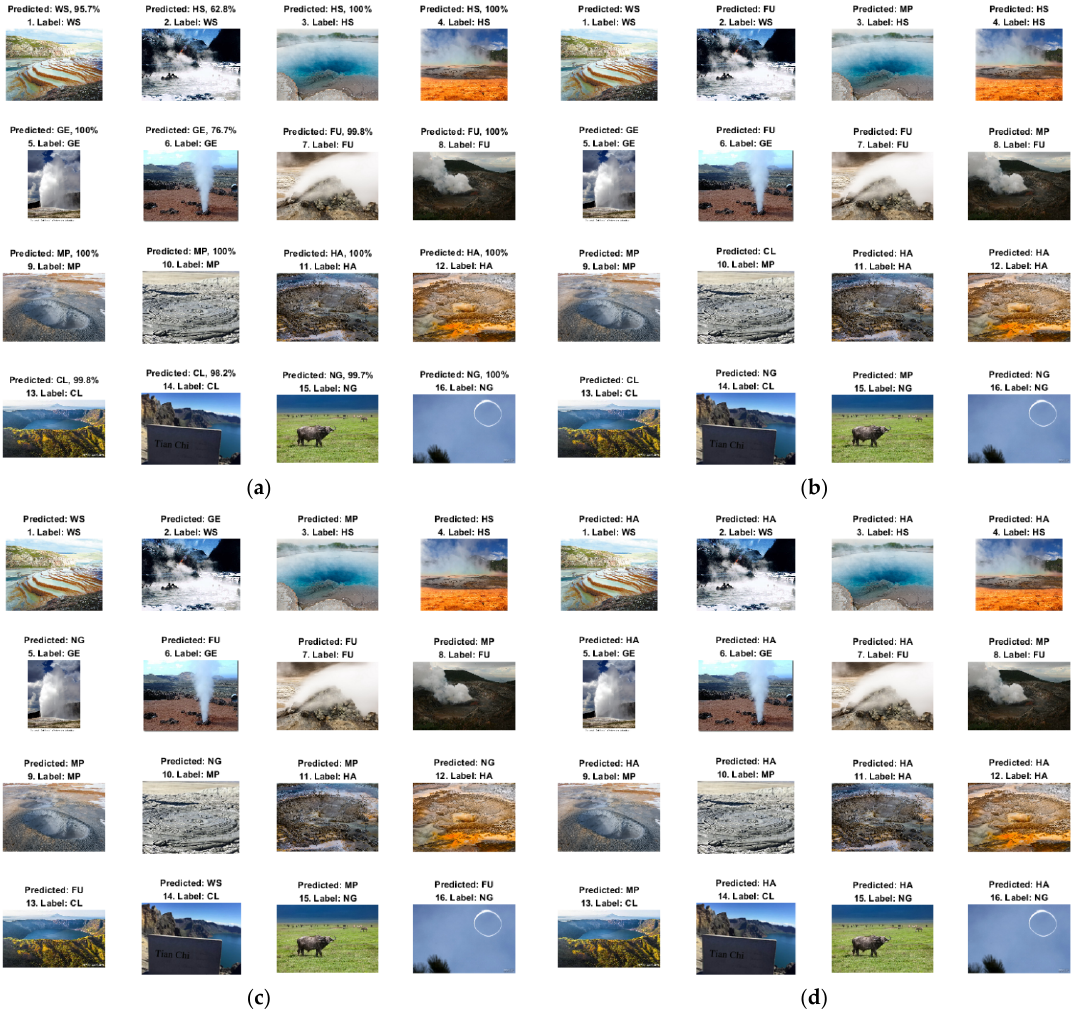
Figure 5. Test image presentations of different classifier models: ( a ) The GoogLeNet model, ( b ) the Support Vector Machine (SVM) model, ( c ) the Decision Tree (DT) model, and ( d ) the K-Nearest Neighbor (KNN) model. WS is short for warm spring; HS is short for hot spring; GE is short for geyser; FU is short for fumarole; MP is short for mud pot; HA is short for hydrothermal alteration; CL is short for crater lake, and NG is short for none of the geothermal surface manifestations. The maximum probability of an image predicted to be a type is labeled after the abbreviation by the GoogLeNet model. The digital number before “Label” is the numerical order of an image.